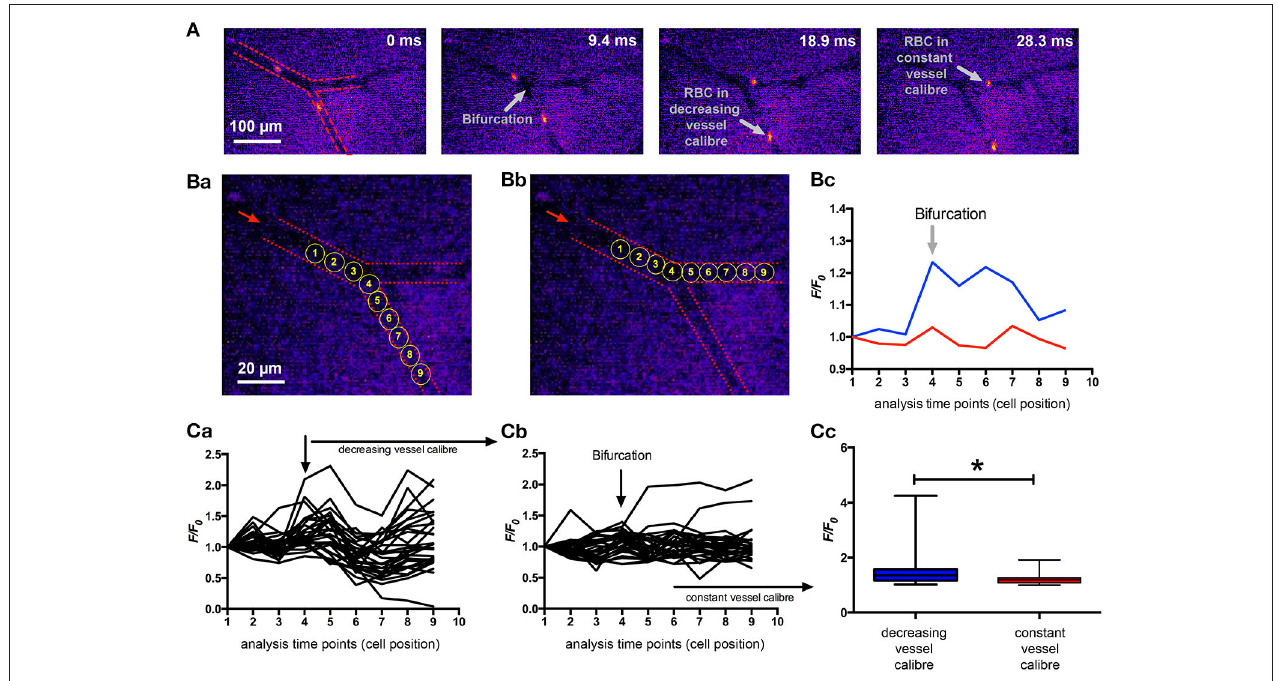
FIGURE 4 | In vivo Ca 2 + -signaling of mouse RBCs when passing through capillaries. Mouse RBCs were ex vivo stained with Fluo-4 and then re-injected into the mouse circulation. Fluorescence imaging of capillaries was performed in the dorsal skinfold chamber. (A) Shows representative snapshots of RBCs passing a bifurcation. For the 30ms sequence only every second recorded image is presented. For a better orientation the vessel walls are indicated by red dashed lines in the leftmost image and further annotations (gray) are added in the other images. (B) depicts the positions where fluorescence intensity (F/F 0 ) was analyzed for a decreasing vessel caliber (Ba) and for a constant vessel caliber (Bb) of the same example section as in (A) . The dashed red lines mark the vessel walls, the red arrow indicates the blood flow direction and the yellow circles depict the analysis positions which are plotted in the following diagrams. Example fluorescence traces of the two cells analyzed as pointed out in (Ba,Bb) are shown in (Bc) . Videos of these two example cells are available in the supplemental material (Supplemental Videos 3, 4, respectively). (C) depicts the analysis of 30 cells passing through a capillary with decreasing vessel caliber and 28 cells passing through a capillary with constant vessel caliber. Analysis was performed at three vessel-bifurcations in two mice. The fluorescence intensity (F/F 0 ) traces of all measured RBCs passing through a capillary with decreasing vessel caliber is plotted in (Ca) , while the traces of all measured RBCs passing a capillary with constant vessel caliber is plotted in (Cb) . The statistical analysis of the maximal fluorescence intensity (F/F 0 ) of RBCs from both groups is depicted in (Cc) . The increase in Ca 2 + , while passing through a vessel with decreasing caliber is significant ( p = 0.014; *).